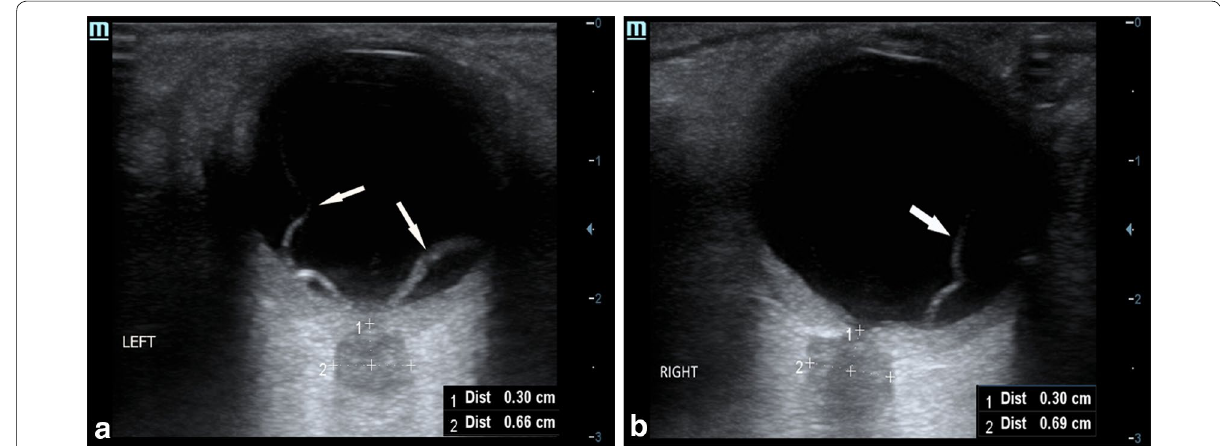
Fig. 1 a Ocular ultrasound of the left eye demonstrating retinal detachment (white arrows) and optic nerve sheath diameter enlargement. b Ocu- lar ultrasound of the right eye demonstrating retinal detachment (white arrow) and optic nerve sheath diameter